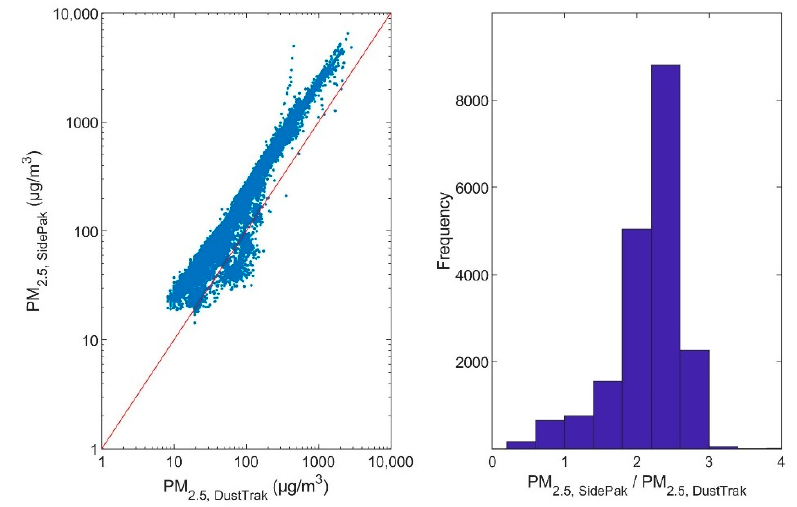
Figure 3. Comparison between the PM 2.5 concentrations measured with the DustTrak and SidePak.